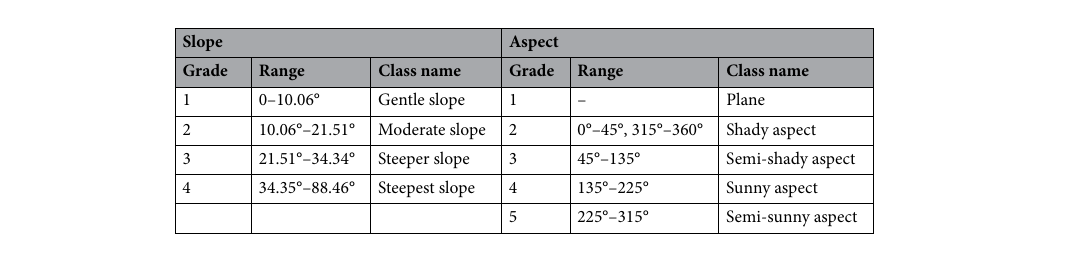
Table 2. Slope and aspect